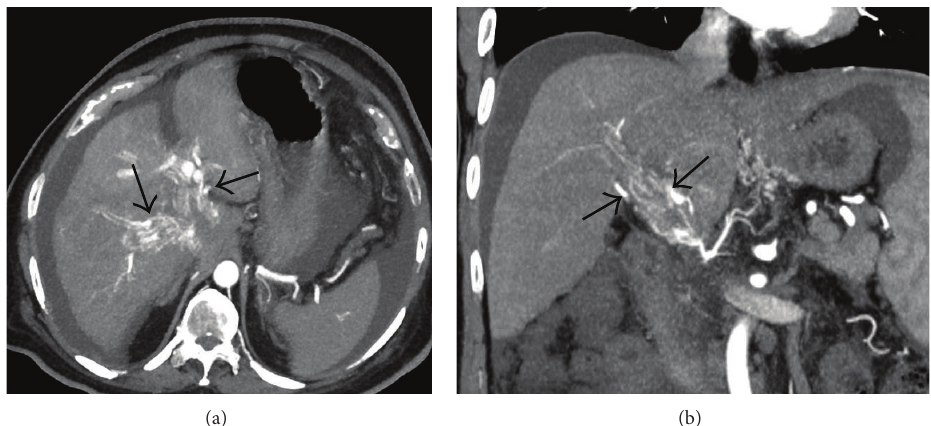
Figure 49: Axial (a) and coronal (b) MIP images of a patient with liver cirrhosis and multifocal hepatocellular carcinoma demonstrating multiple thin streaks of arterial phase enhancement within the main portal vein (arrows in (b)) as well as its intrahepatic branches (arrows in (a)) consistent with tumor thrombus ( threads-and-streaks sign